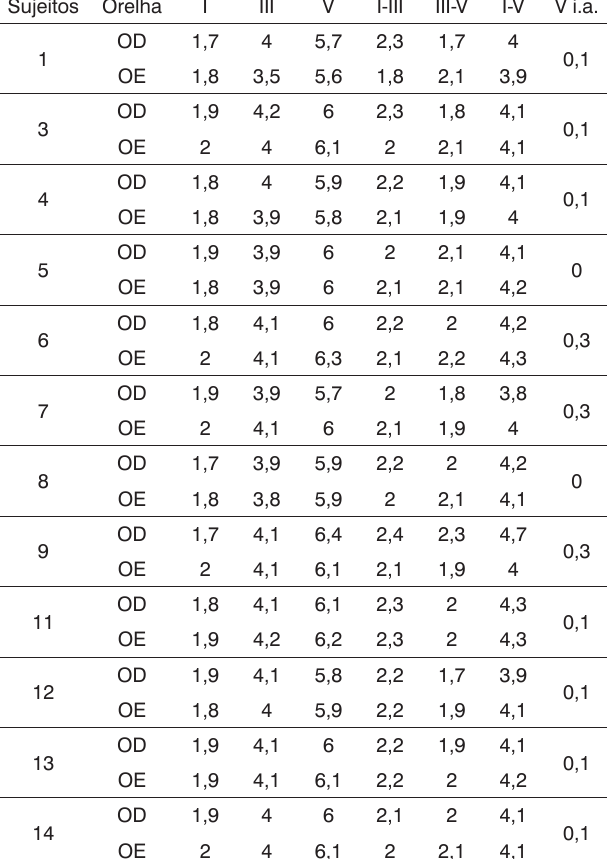
Tabela 4. Resultados do PEATE dos pacientes com a síndrome G/BBB (latências em